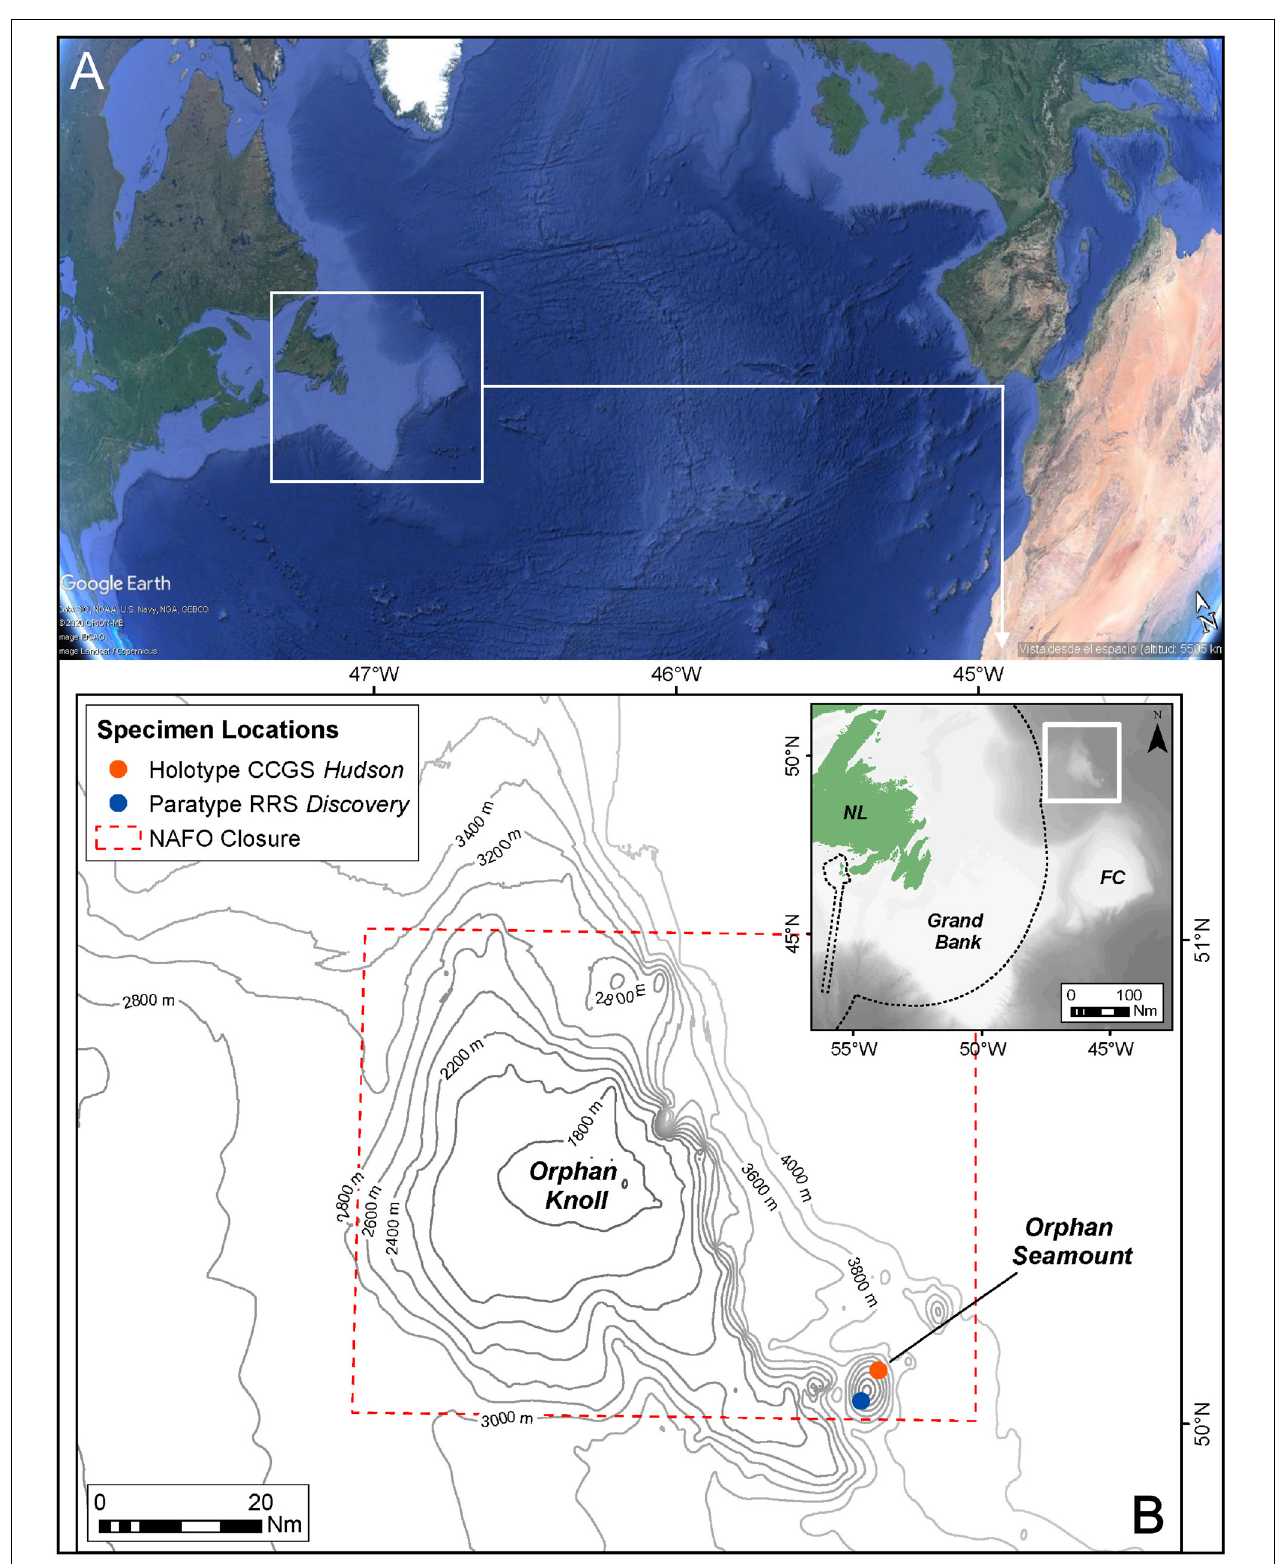
FIGURE 1 | Location of sampling sites of new species. (A) Situation of Orphan Knoll in the North Atlantic (from Google Earth). (B) Positions of specimens locations (Holotype and Paratype) on Orphan Seamount.